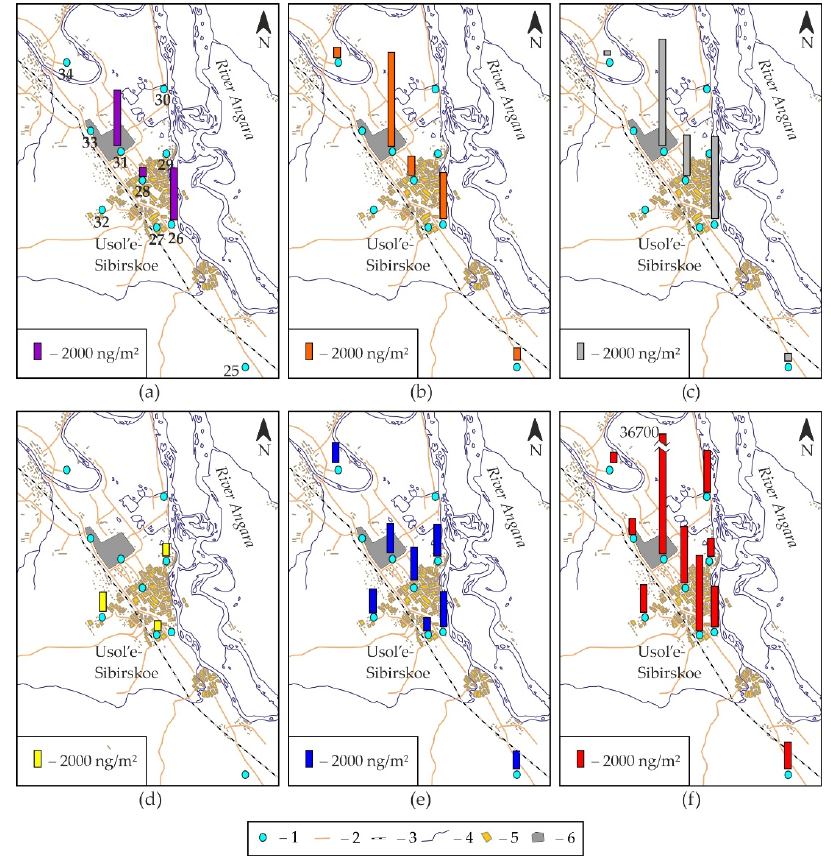
Figure 3. The total PCB levels in the snow in the town of Usol’e-Sibirskoe and the surrounding area in 1996 ( a ) [20,21], 2003 ( b ) [22], 2009 ( c ) [23], 2011 ( d ) [24], 2016 ( e ) [16], and 2021 ( f ) (ng/m 2